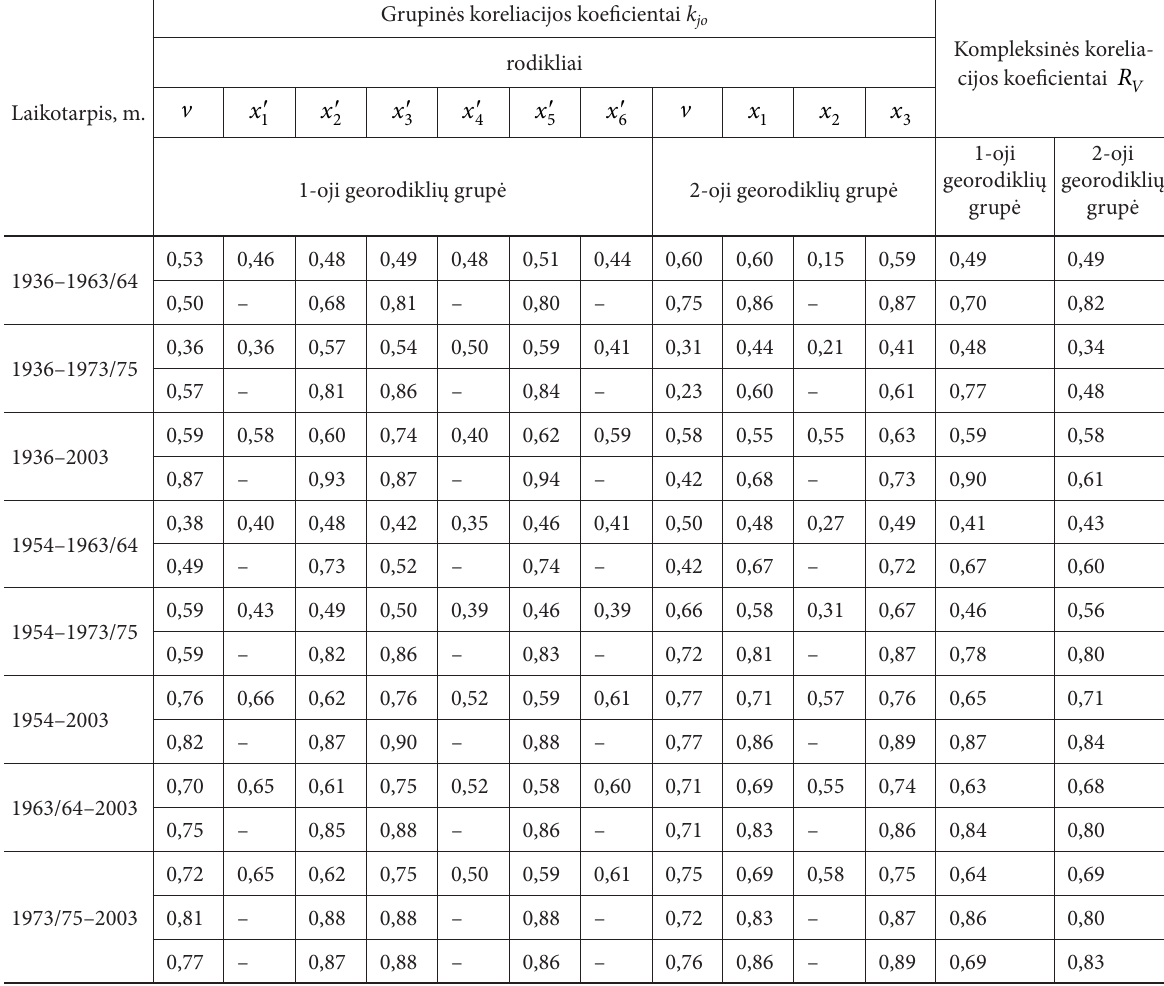
Table 4. Coefficients of the internal complex correlation